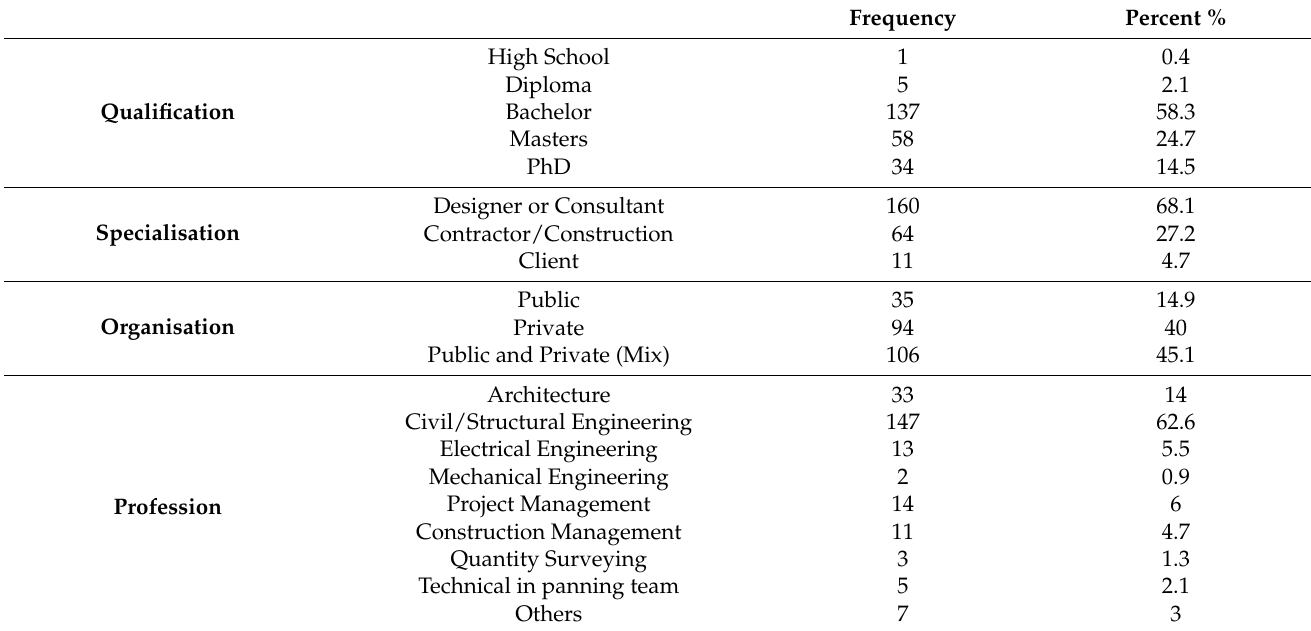
Table 2. Factors affecting